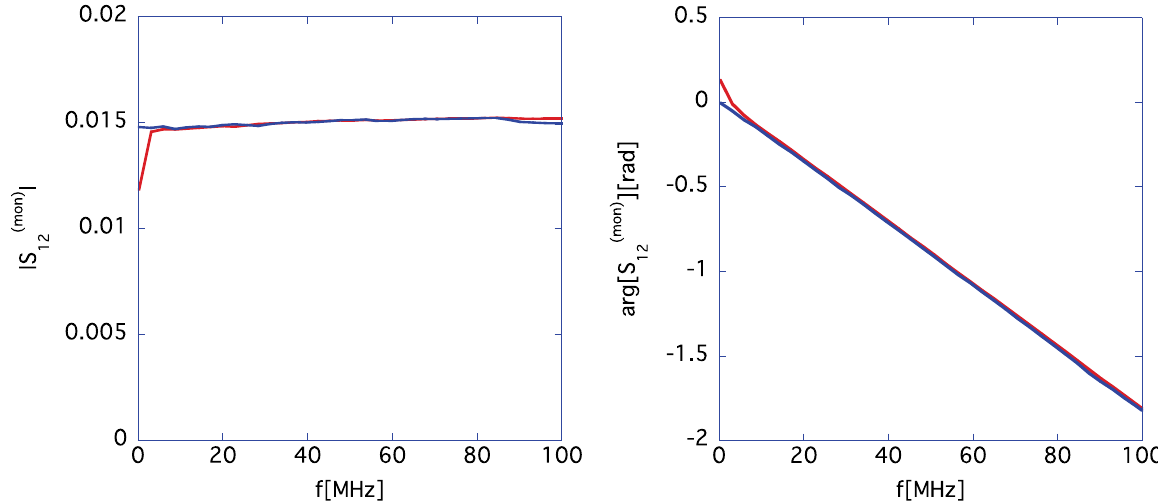
ð mon Þ 12 from 0 to 100 MHz for the ceramic breaks in the lower (red) and upper (blue)